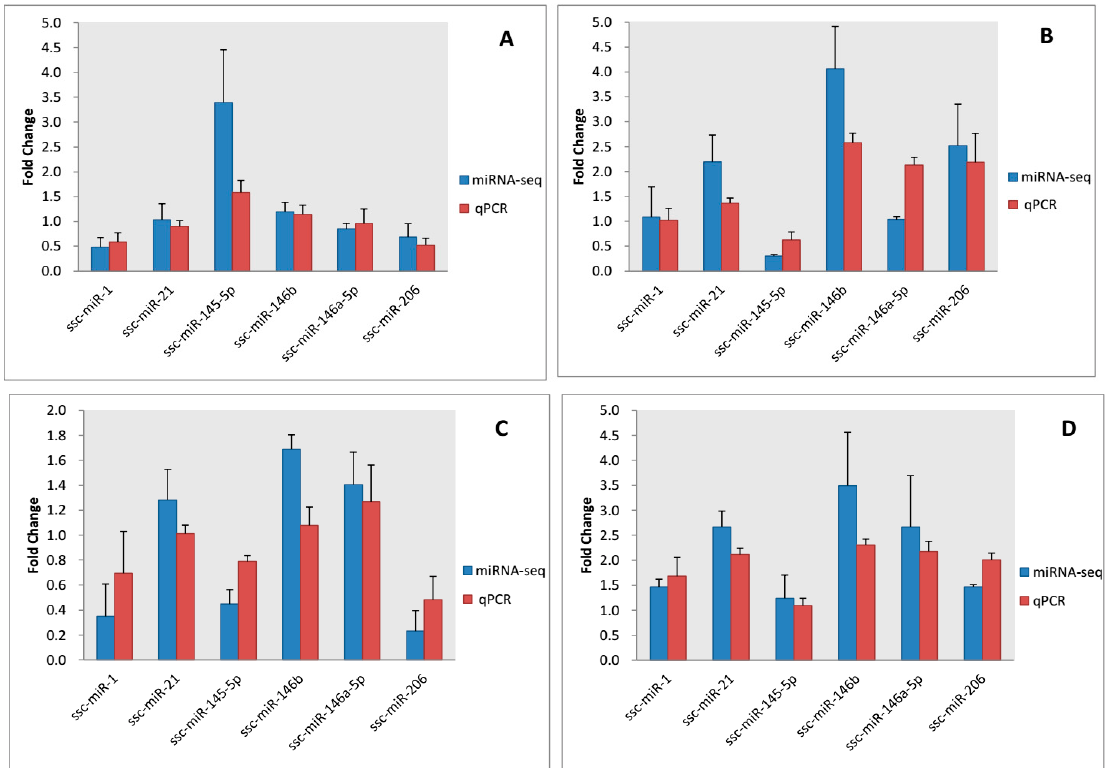
Figure 4. Six differentially-expressed (DE) miRNAs validated by qPCR. ( A ) dorsal subcutaneous adipose tissue at 30 days old; ( B ) dorsal subcutaneous adipose tissue at 90 days old; ( C ) dorsal subcutaneous adipose tissue at 240 days old; and ( D ) abdominal adipose tissue at 240 days old. Four, three, four, and four pool RNA samples were used for miRNA ‐ sequencing (miRNA ‐ seq) or qPCR in ( A – D ).